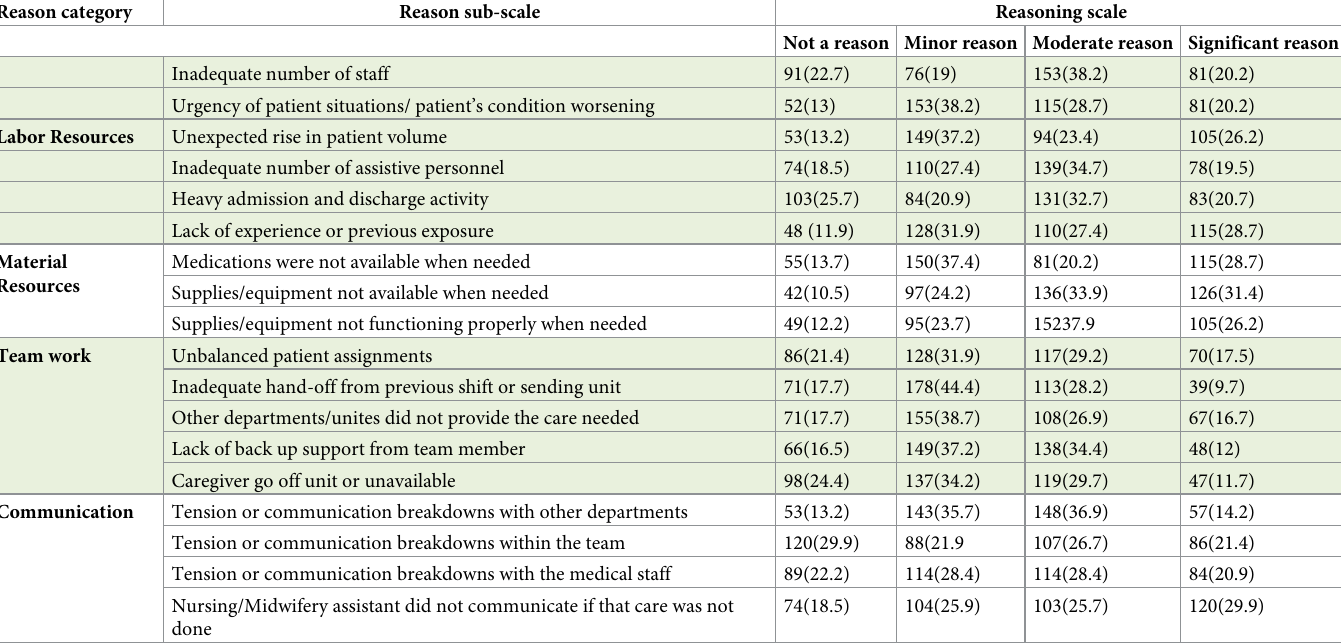
Table 3. Results on reason for commonly missing a nursing care in the perinatal setting (N =